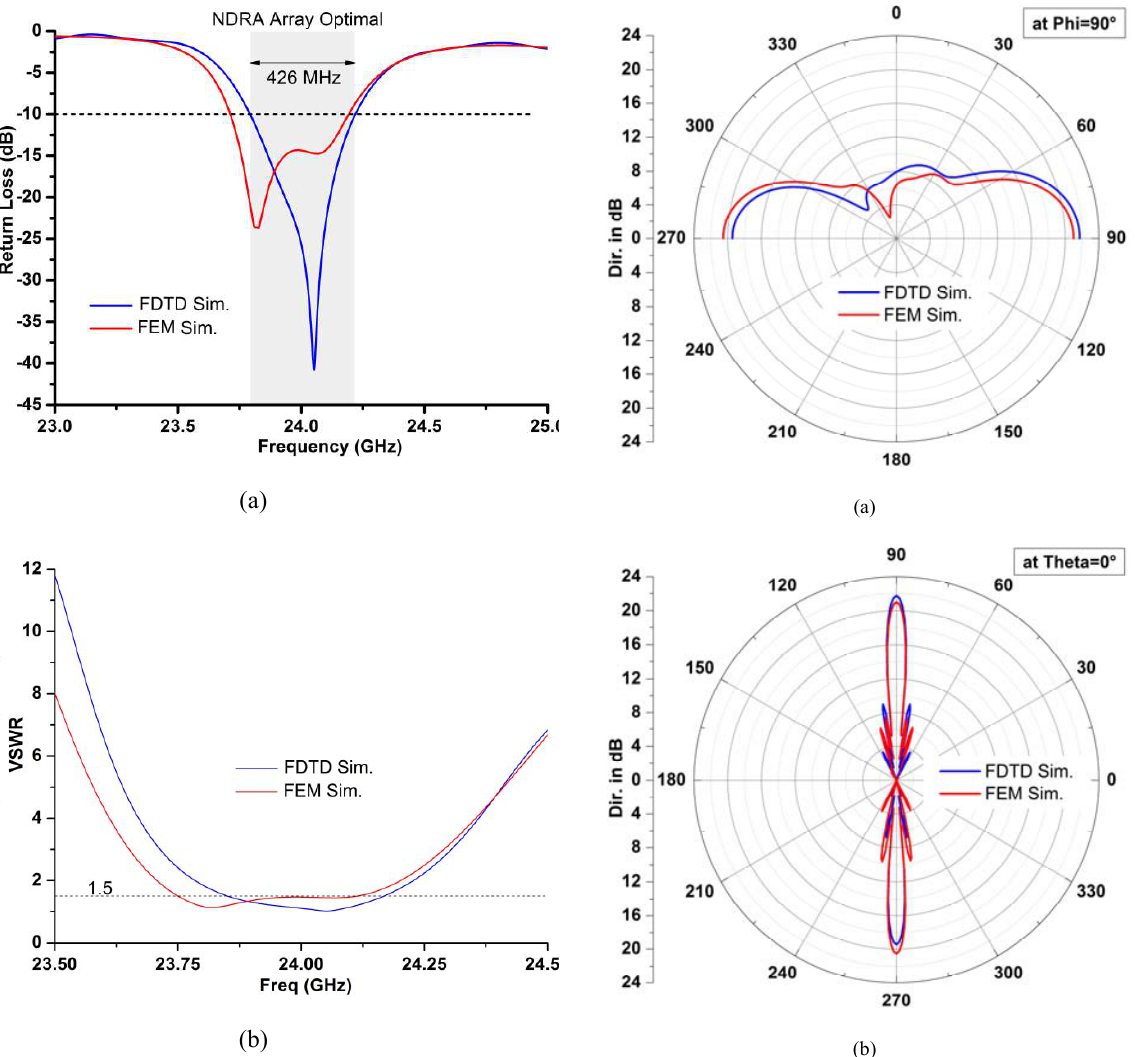
Figure 8: (a) S 11 and (b) VSWR of the proposed optimal NDRA array.